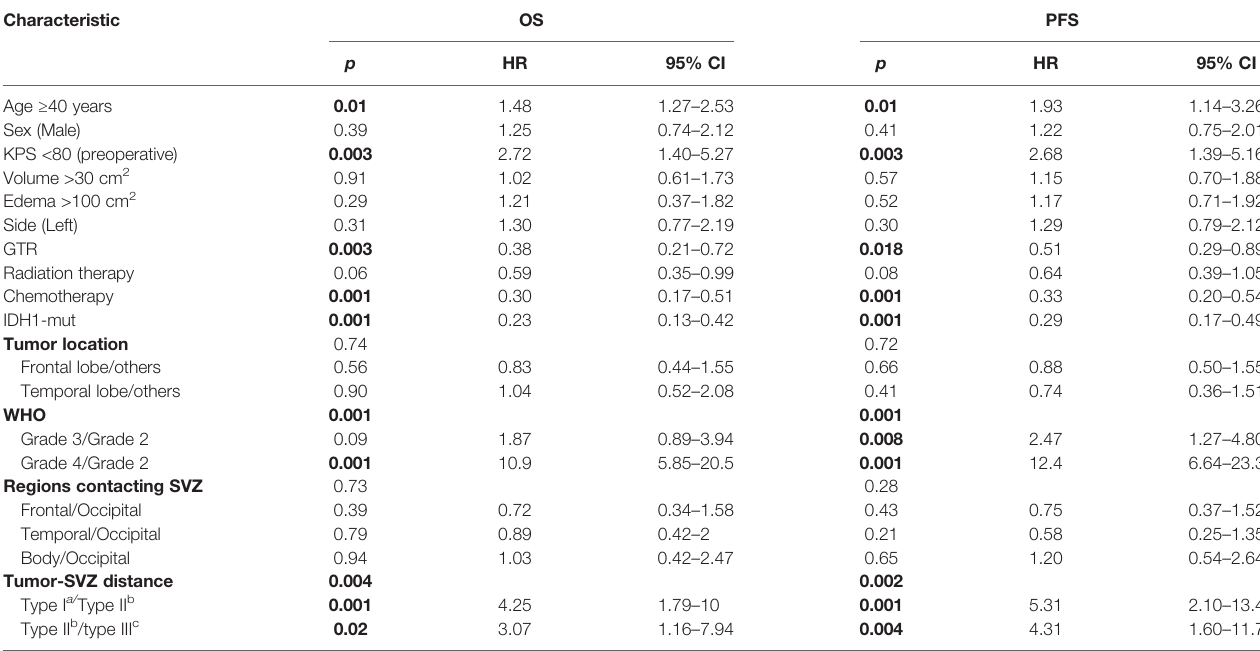
TABLE 2 | Univariate analysis of survival outcomes in all patients.